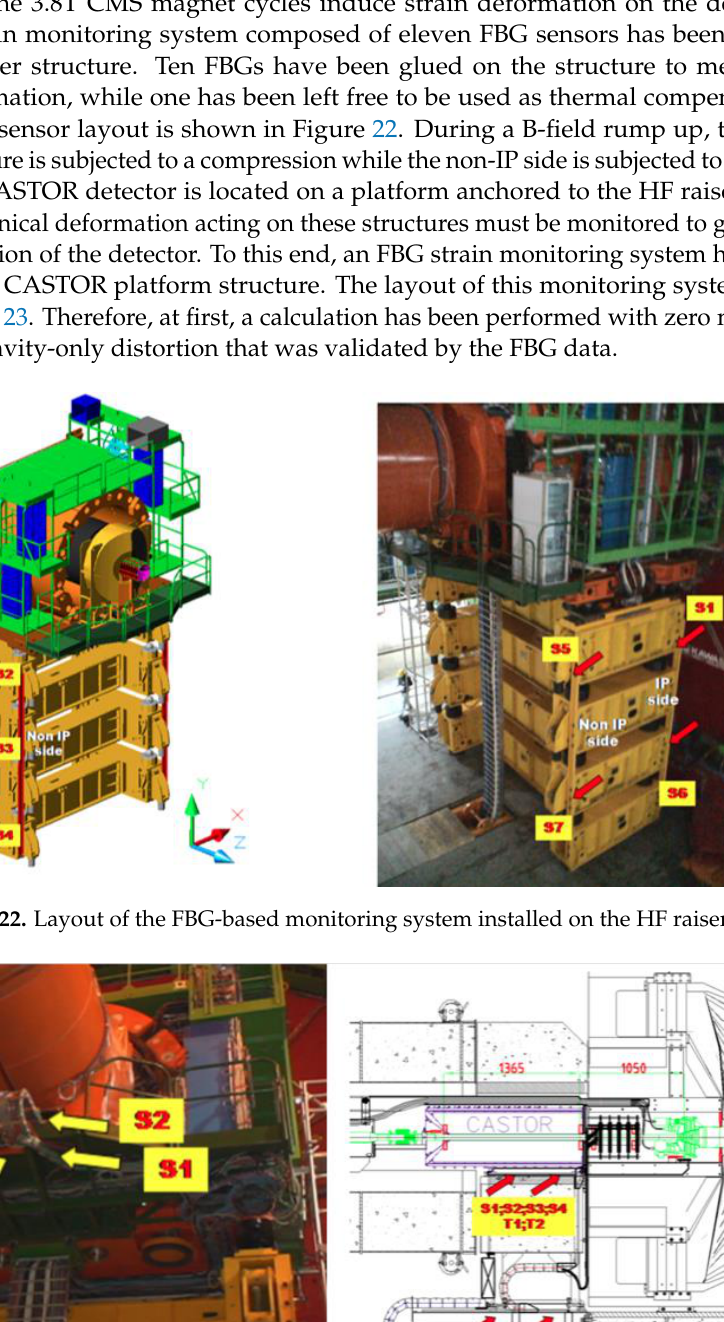
Figure 21. Integration of the FBG data taking system in the CMS Detector Control System.